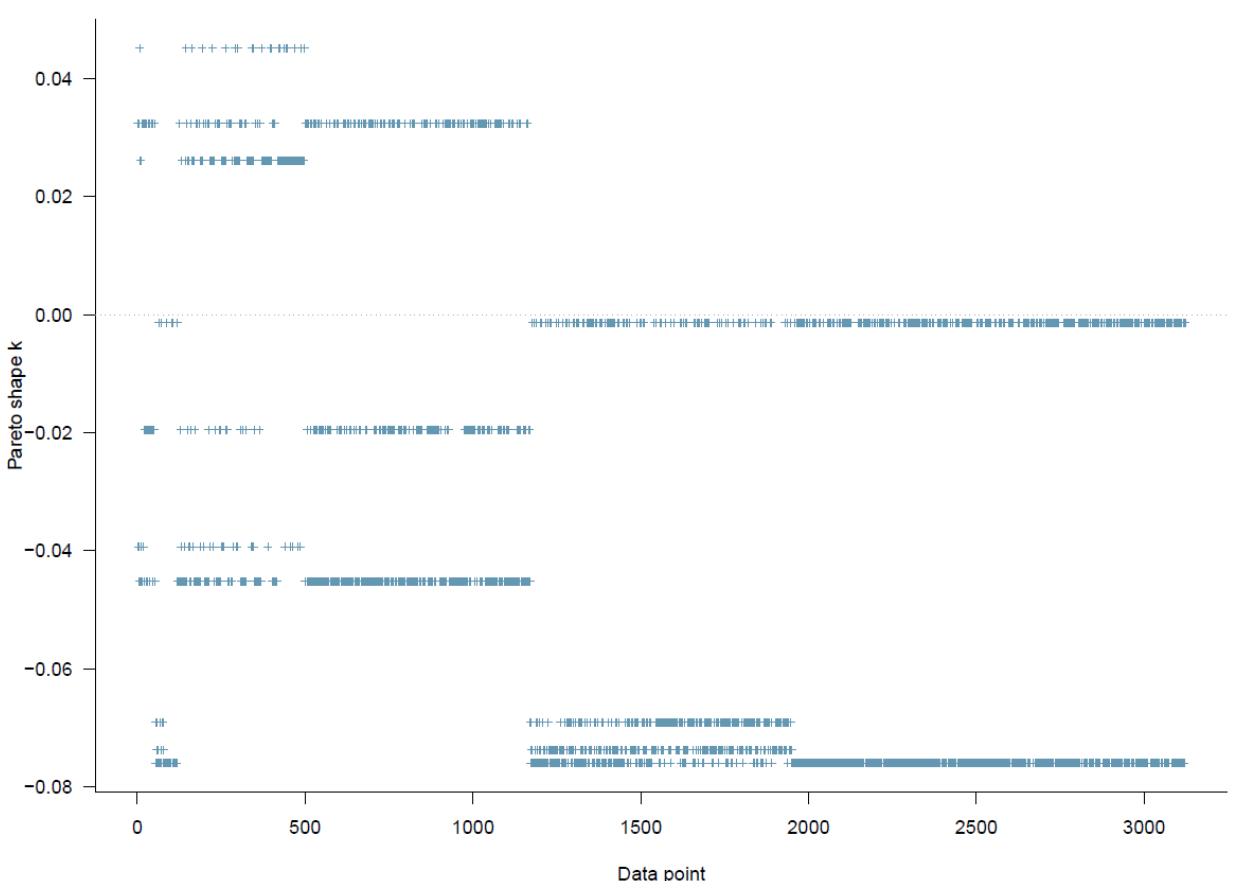
Figure 5. Pareto smoothed importance-sampling (PSIS) diagnostic plot.